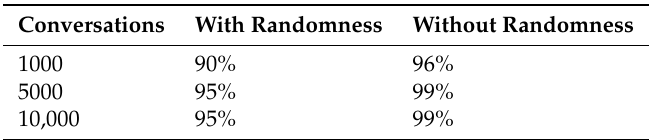
Table 3. Accuracy in cross-validation for the protocol model obtained from interactions using the argumentation protocol. Conversations With Randomness Without Randomness 1000 90% 96% 5000 95% 99% 10,000 95%